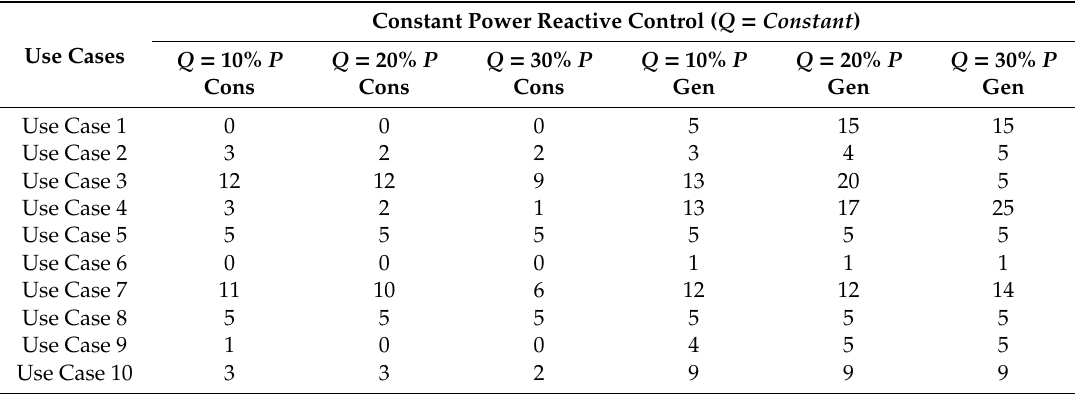
Table A4. Constant reactive power control: Voltage deviations.